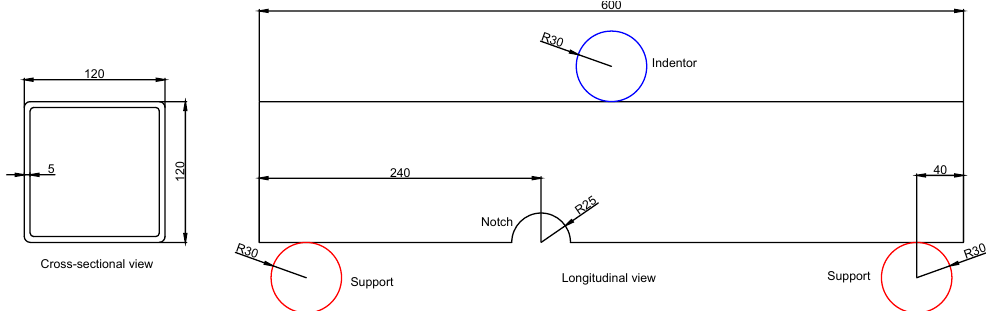
Figure 1. Dimensions of the test models (unit: mm) and the experimental setup in the quasi- static